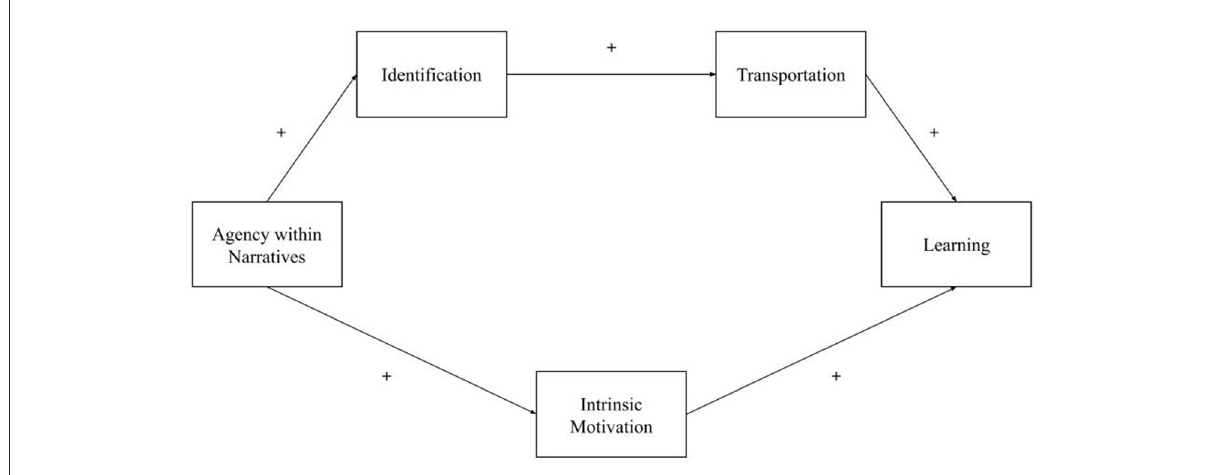
FIGURE1 The conceptual model.